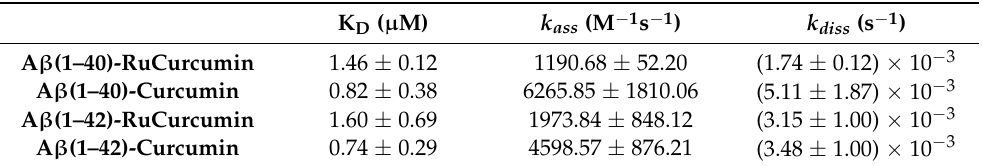
Table 2. Comparison of kinetic and equilibrium parameters for the binding of curcumin and RuCur- cumin to amyloid peptides.